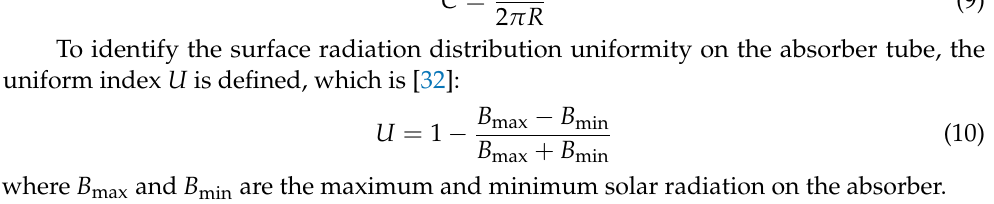
Figure 4. Schematic of a TTC model.